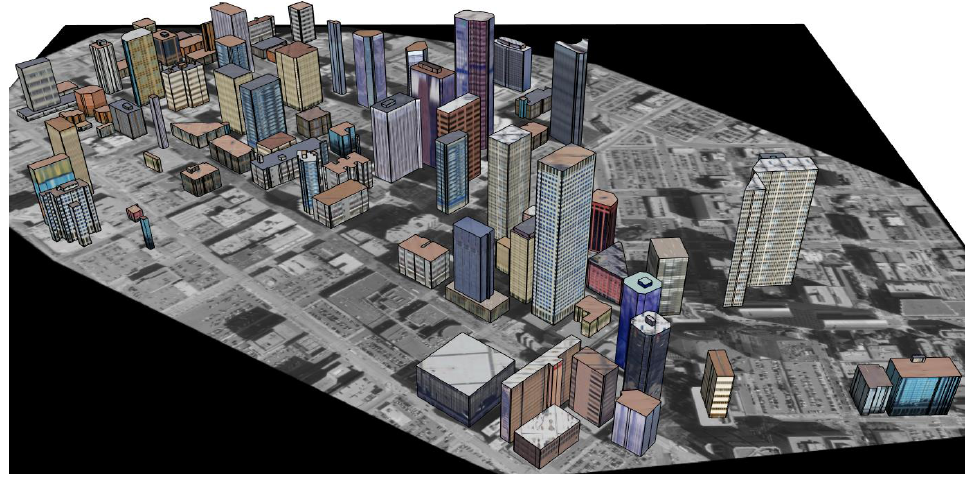
Figure 7. Combination of urban building model and